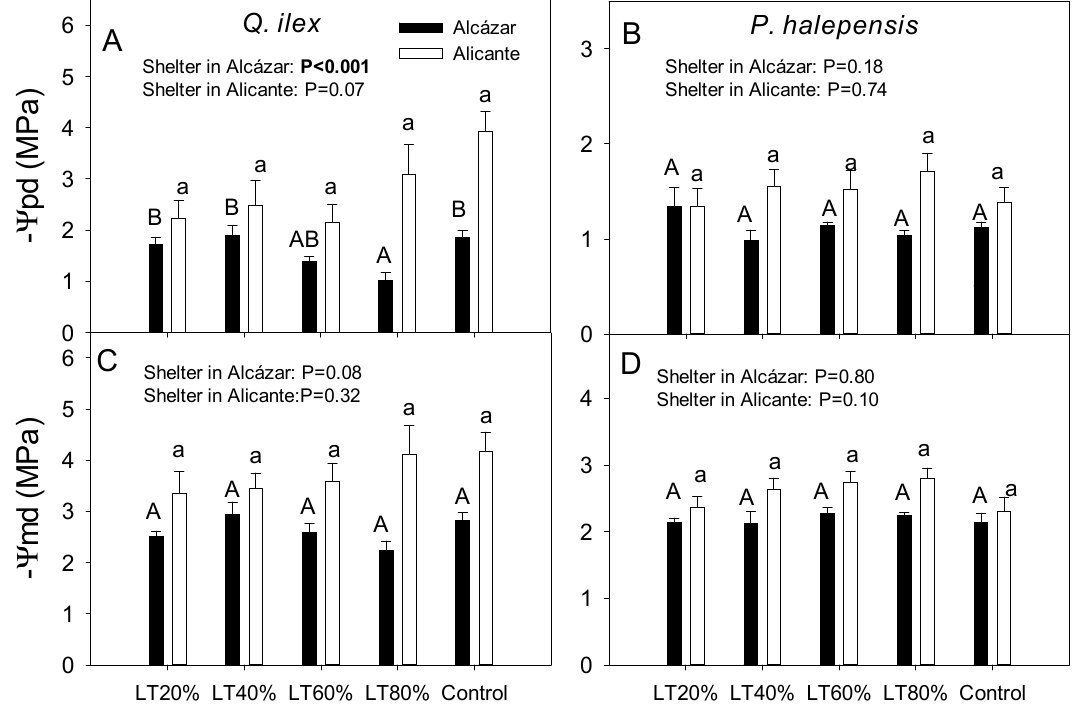
Figure 4. Mean values ( n = 6–10) of predawn ( Ψ pd , A , B ) and midday Ψ md , C , D ) water potential of Q. ilex ( A , C ) and P. halepensis ( B , D ) seedlings at the end of the first dry season (end of August 2010) for the different shelter treatments (control mesh plus a gradient of wall light transmissivity ranging from 20 to 80% of incident radiation) in each site (Alcázar and Alicante). Error bars represent standard error. Different capital letters denote homogenous groups of shelter treatments within Alcázar, while small letters apply to Alicante (Tukey, α = 0.05). For each variable, species, and site, the results of the one-way ANOVA (Shelter) are depicted in each panel.